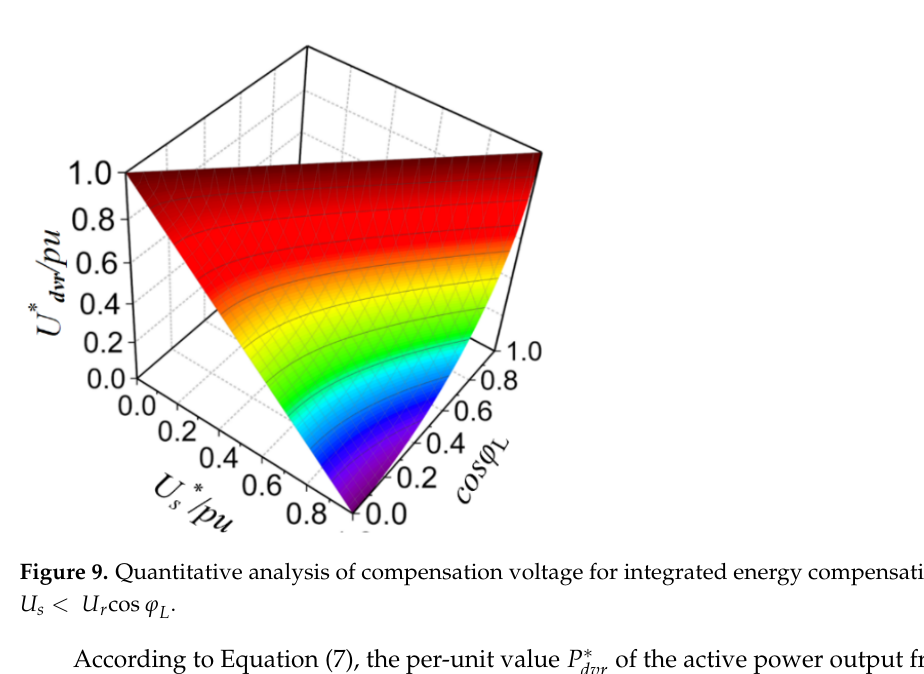
Figure 10. Quantitative analysis of optimal energy compensation with U s < U r cos φ